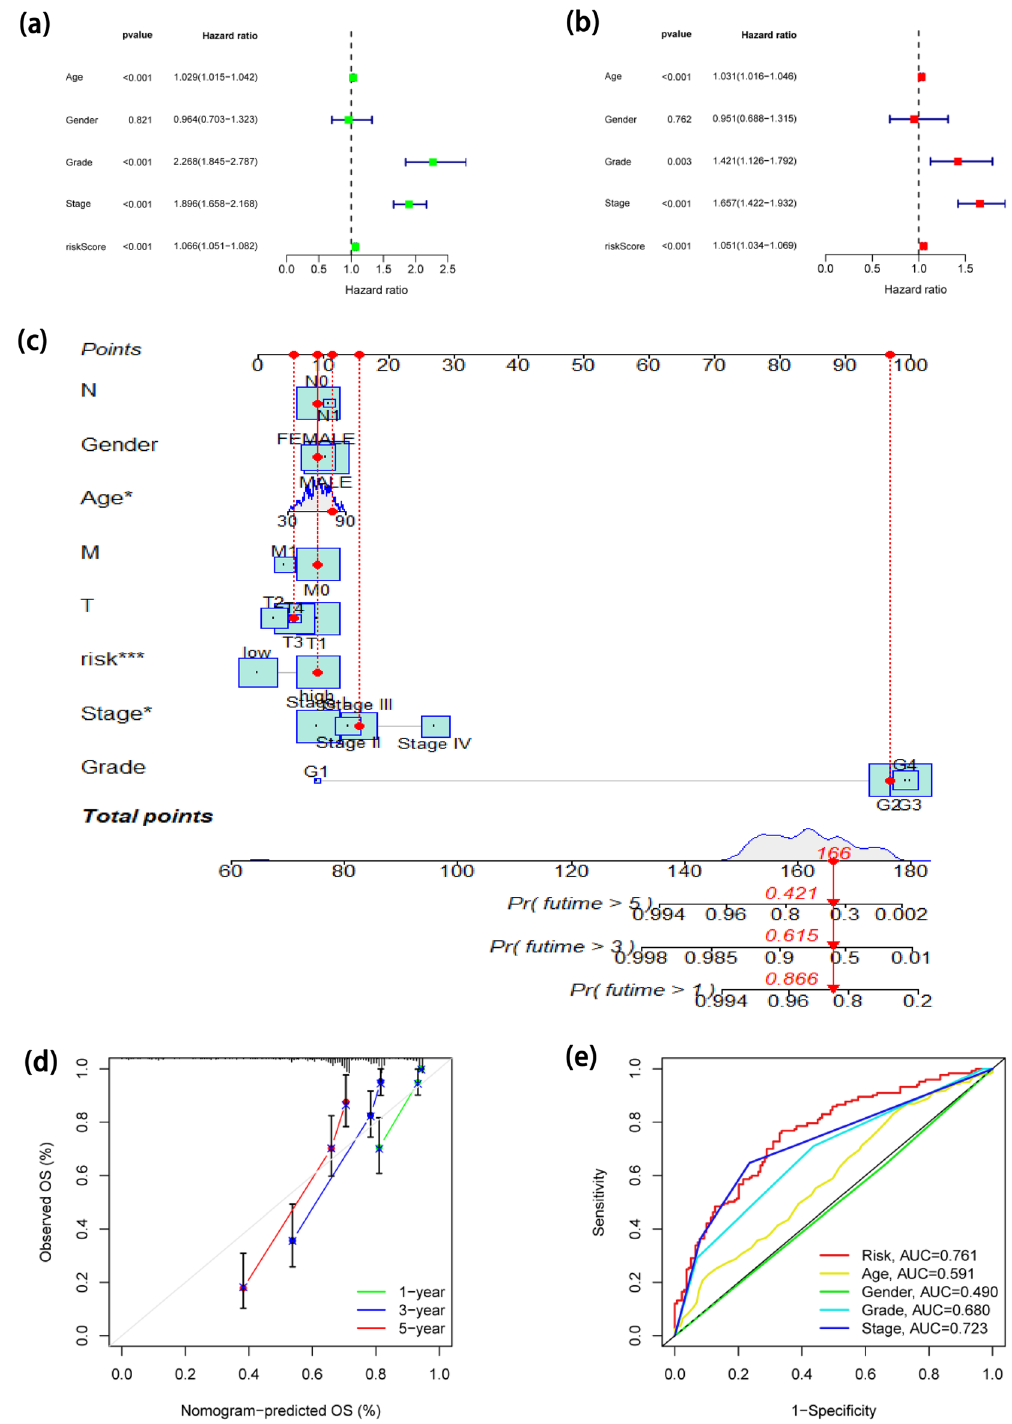
Figure 4. Evaluation of FLPS and development of FLPS-based nomogram. ( a ) Univariate Cox regression analysis for the OS of ccRCC. ( b ) Multivariate Cox regression analysis for the OS of ccRCC. ( c ) A nomogram based on all independent predictive variables. ( d ) Calibration curves for the nomogram. ( e ) ROC curves for predicting OS at 5